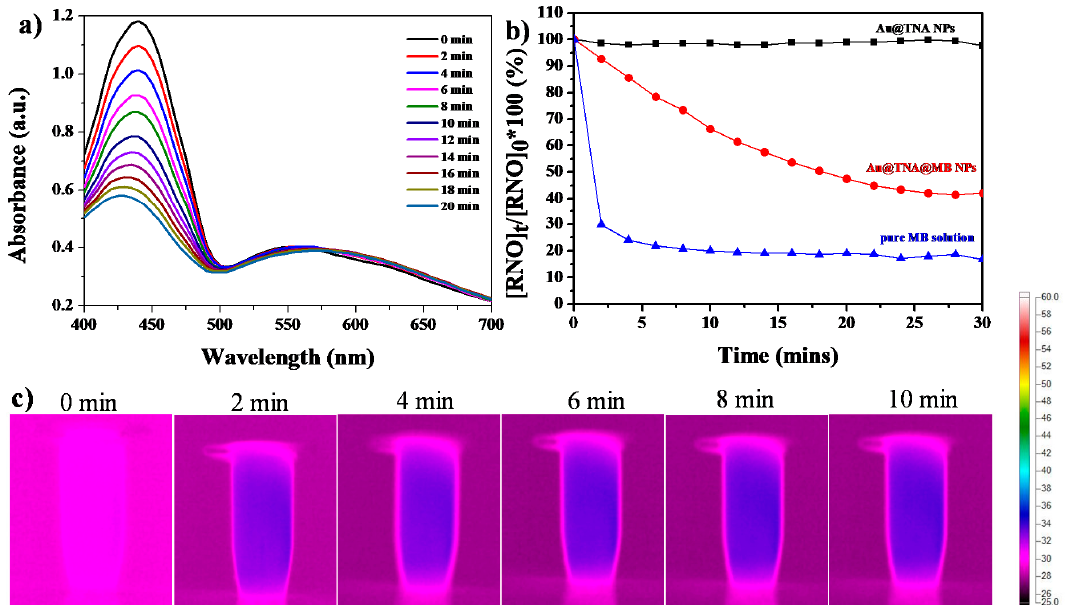
Figure 3. UV-visible spectra ( a ) and relative intensity at 440 nm ( b ) of the N,N- dimethyl-4-nitrosoaniline (RNO)/imidazole indicator for measuring single oxygen generation from Au@TNA@MB NPs as a function of the irradiation time at 650 nm. Pure MB and Au@TNA are presented as control groups. ( c ) Thermographic images mapping the temperature increase of 25 ppm [Au] Au@TNA@MB NPs at 650 nm (125 mW/cm 2 ).